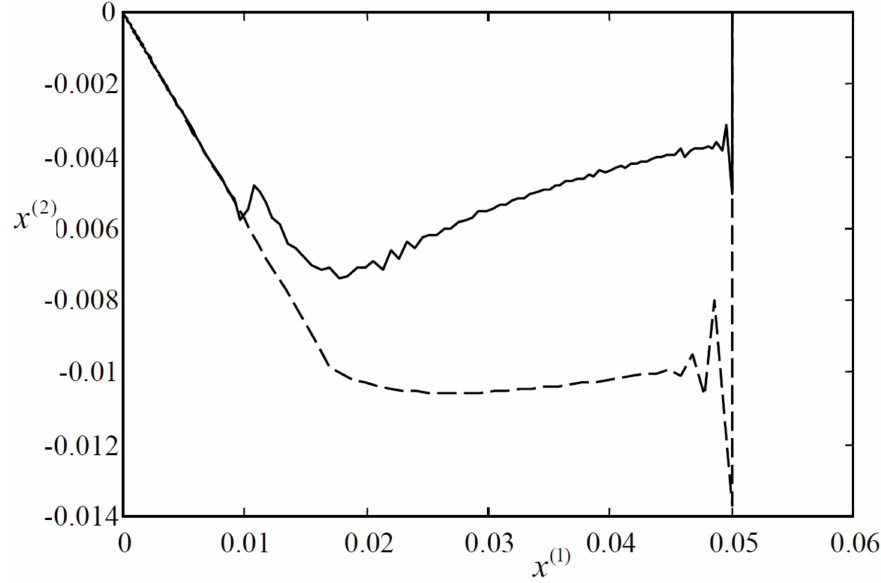
Figure 3. The state trajectories of the closed-loop systems (dashed line for Algorithm 1, solid Algorithm 3).